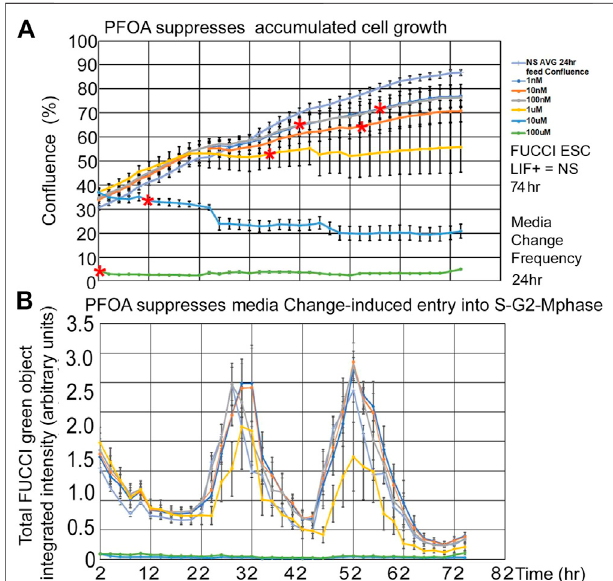
FIGURE5| ThreehighestPFOAdosessuppressentryintothecellcycle, but only the two highest doses suppress the lagging phase accumulated growth measured by con fl uence. FUCCI ESCs were cultured in a live imager with 2-h time-lapse for con fl uence and green fl uorescence for six doses of PFOA from 1 – 10 – 100nM and 1 – 10 – 100uM added to NS media. (A) Cells weremeasuredintime-lapseeverytwo hoursforcon fl uenceintheliveimager. Asthecellsgrowforalongerperiod,theeffectofthedosesincreases,causing the LOEL to be a lower dose. Red asterisks show the timepoint where con fl uence becomes signi fi cantly different than 0 nM PFOA/NS (the direness points of departure). (B) Green cell cycle entry into the S-G2-M-phase was measured simultaneously with con fl uence measurements in A and after feeding at day 1 and 2. In general, the green peak decreases as the dose of PFOA increases. NS (0 dose): N is described in Figure 1 . PFOA: four biological experiments. N (cid:1) 8 for each dose except 100 uM where N (cid:1) six or eight depending on the